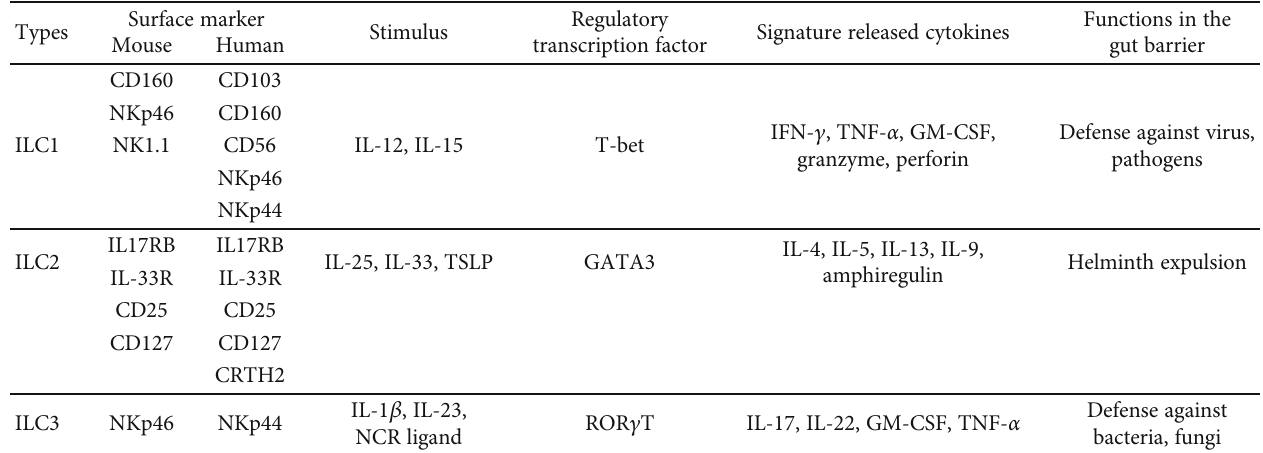
Table 2: Innate lymphoid cells in the